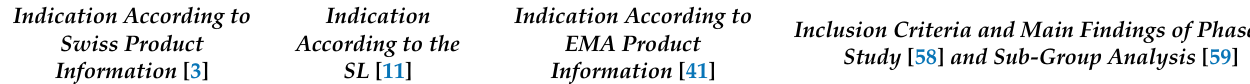
Table 6. Siponimod (Mayzent ® ), approval CH